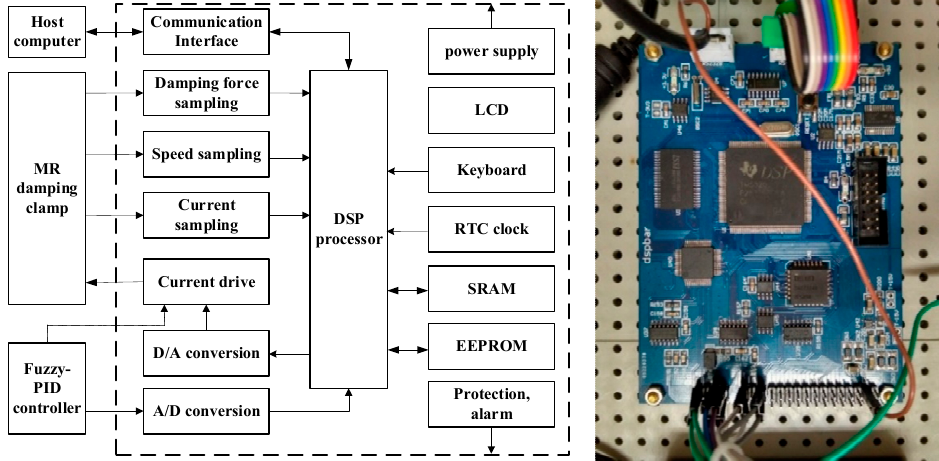
Figure 12. Structure diagram of pipeline vibration control system.